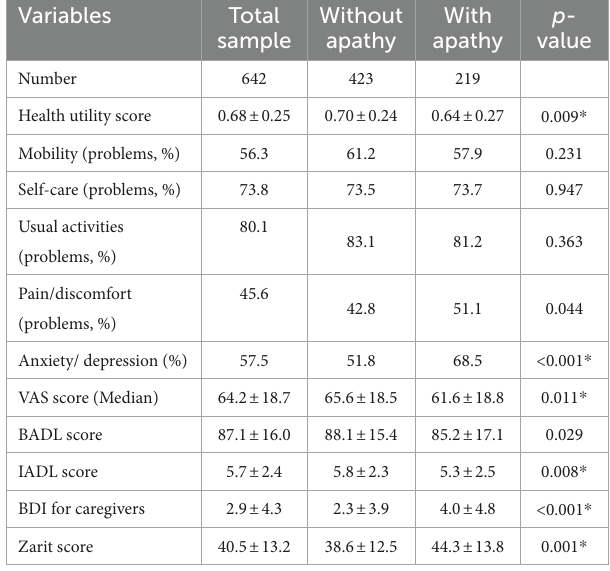
TABLE 3 Health-related quality of life of ALS patients and